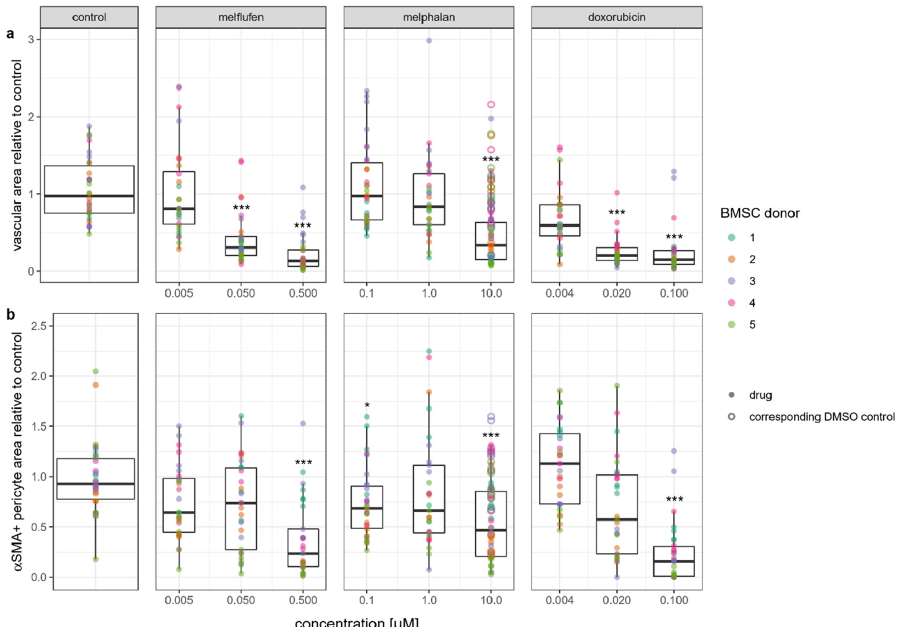
Figure 15. Quantitative analysis of vascular network formation in the presence of drugs: ( a ) quantification of vascular area covered by GFP-HUVECs; ( b ) pericyte area covered by α smooth muscle actin ( α -SMA)-positive BMSCs. Dots represent regions of interest from co-cultures involving color-coded donor BMSC lines with melflufen, melphalan, and doxorubicin added at indicated concentrations. Open circles indicate DMSO vehicle controls for 10 µM melphalan. * denotes p < 0.05, *** denotes p < 0.001 with Dunn’s